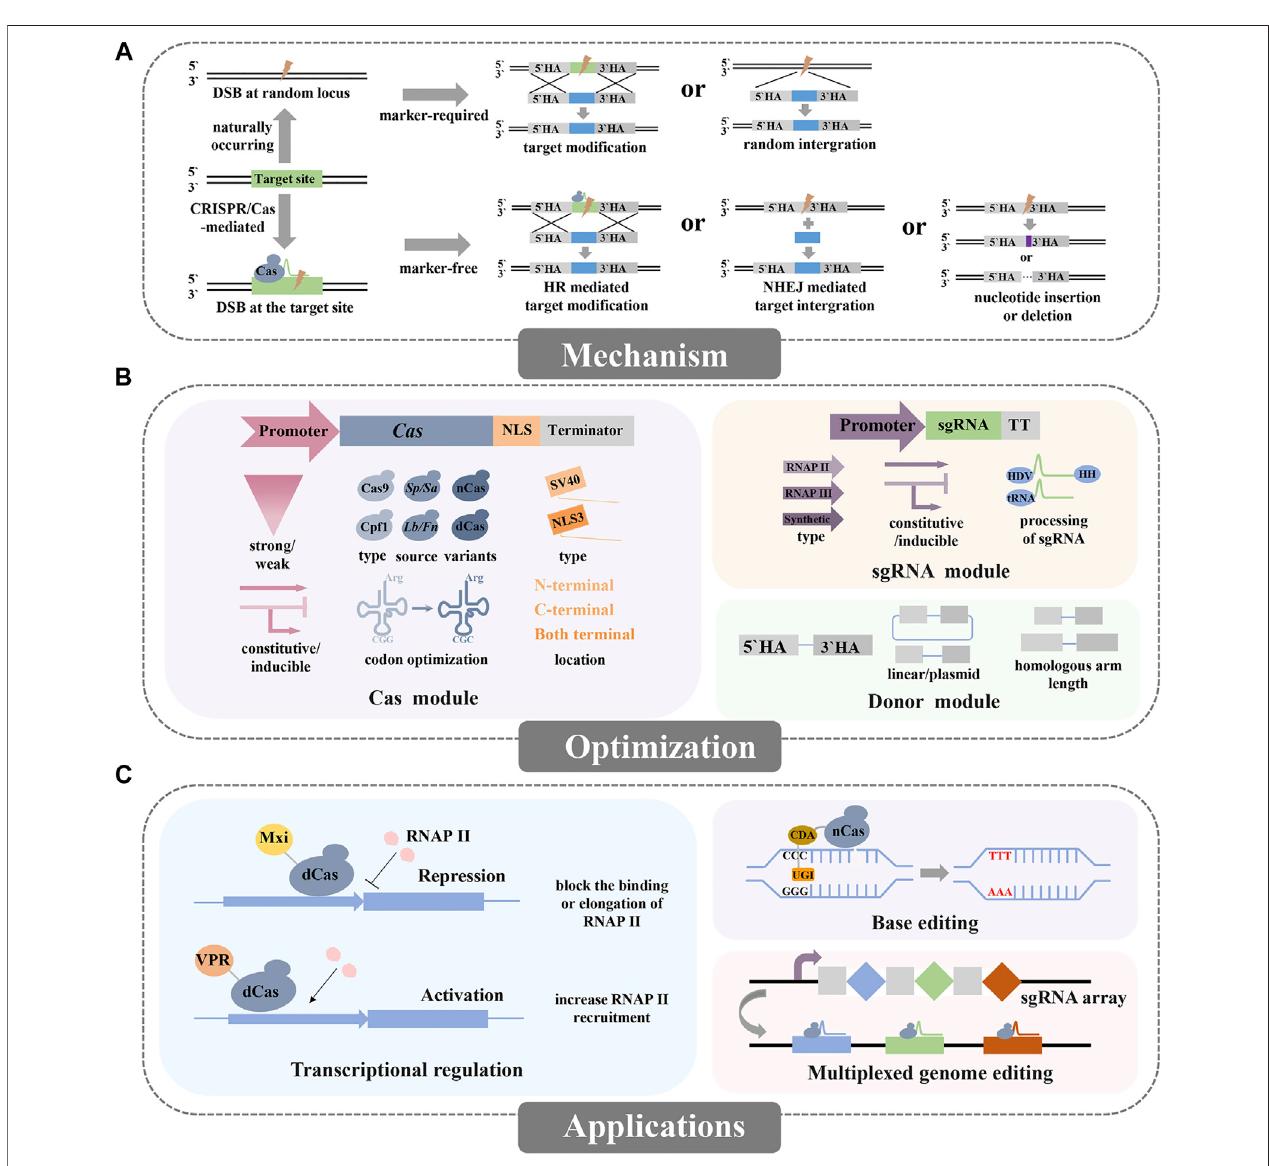
FIGURE 1 | Overview of the mechanism, optimizations, and applications for CRISPR/Cas mediated genome editing in non-conventional yeasts. (A) Genome editing via naturally occurring and CRISPR/Cas-mediated DNA repair mechanisms. (B) The optimizations of the CRISPR/Cas system include the Cas module, sgRNA module, and donor module. (C) The applications of the CRISPR/Cas system mainly include the basic applications (knockin or knockout) and advanced applications (repression, activation, base editing or multiplexed genome editing).